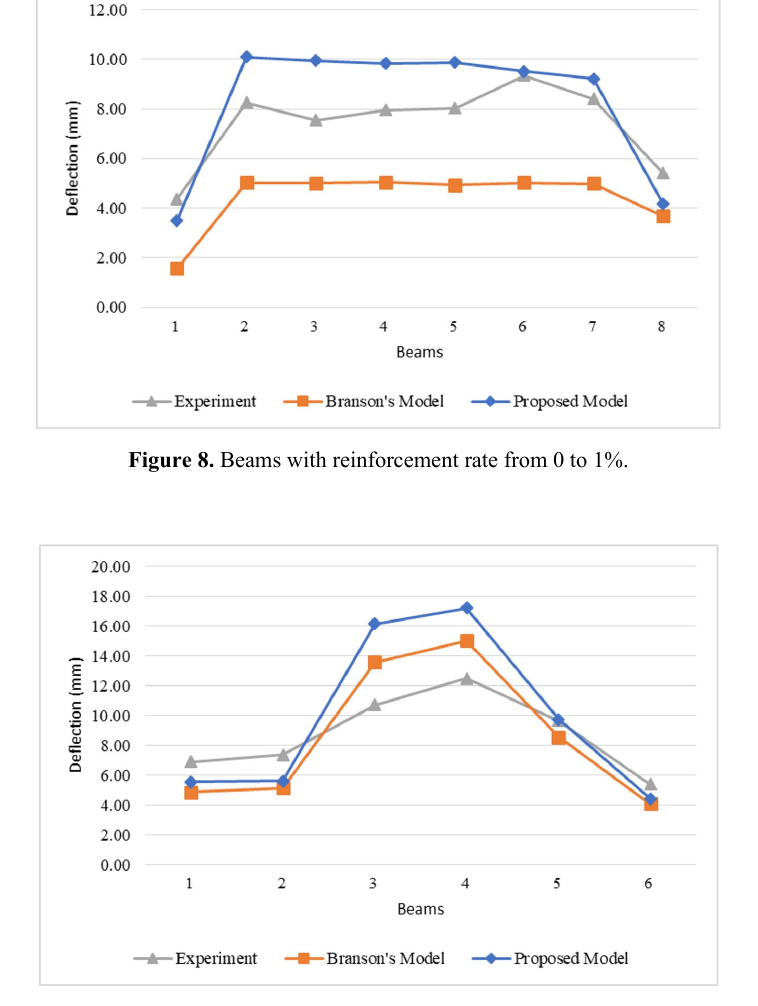
Figure 9. Beams with reinforcement rate from 1 to